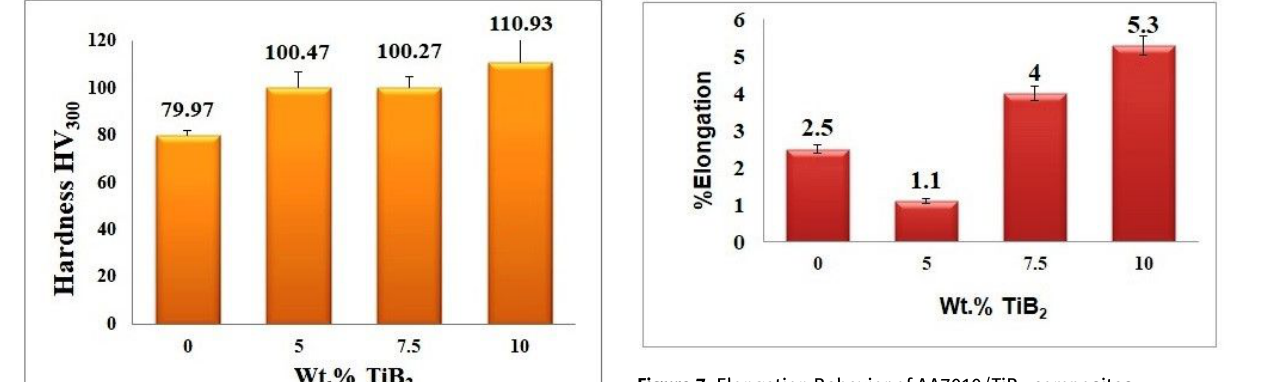
Figure 7: Elongation Behavior of AA7010/TiB 2